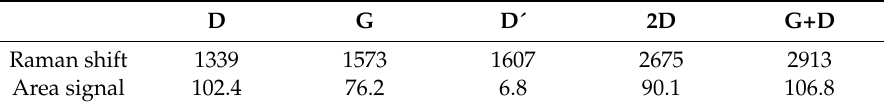
Table 2. Raman data of the multiwalled carbon